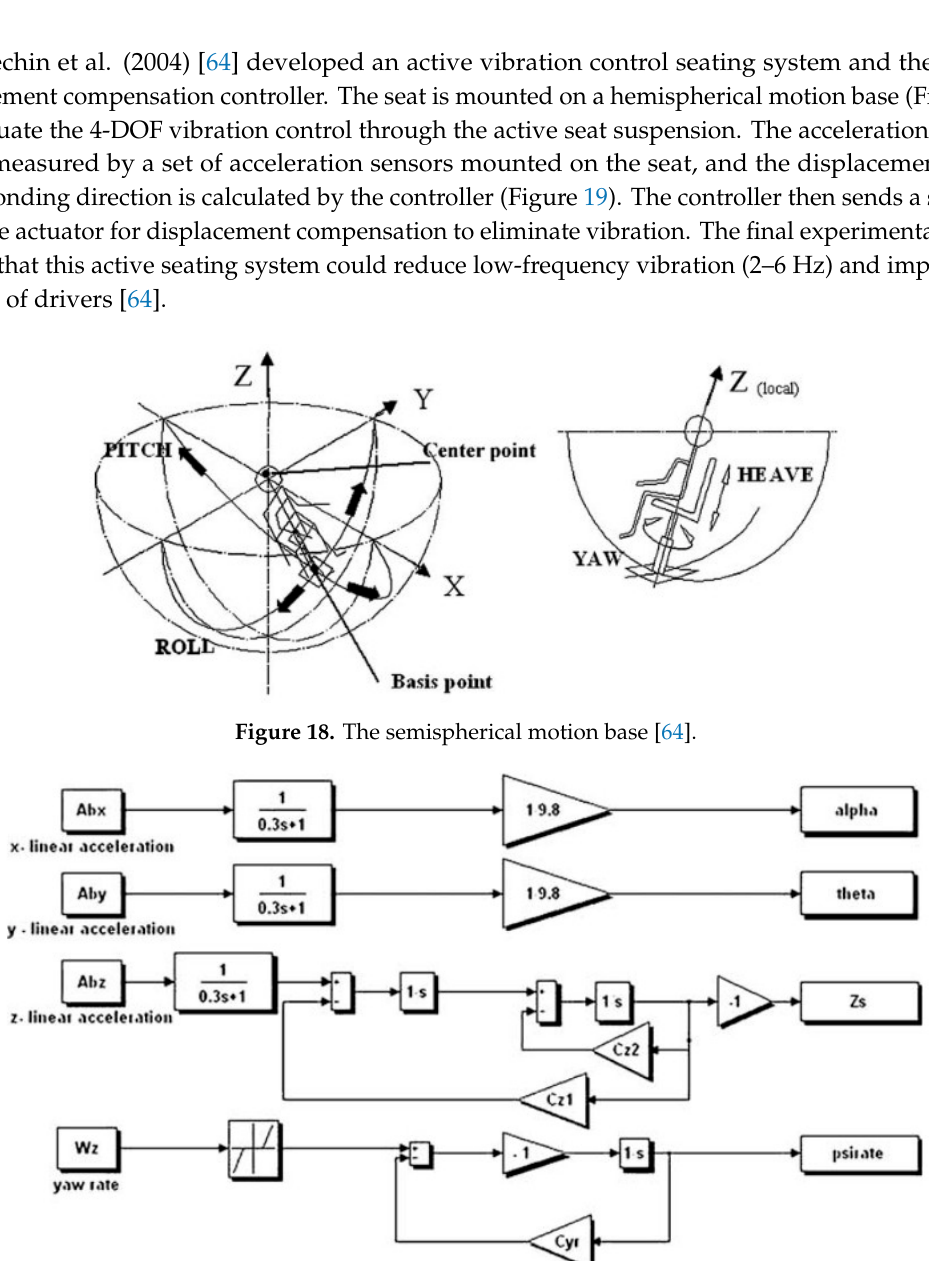
Figure 19. Control algorithm design [64].